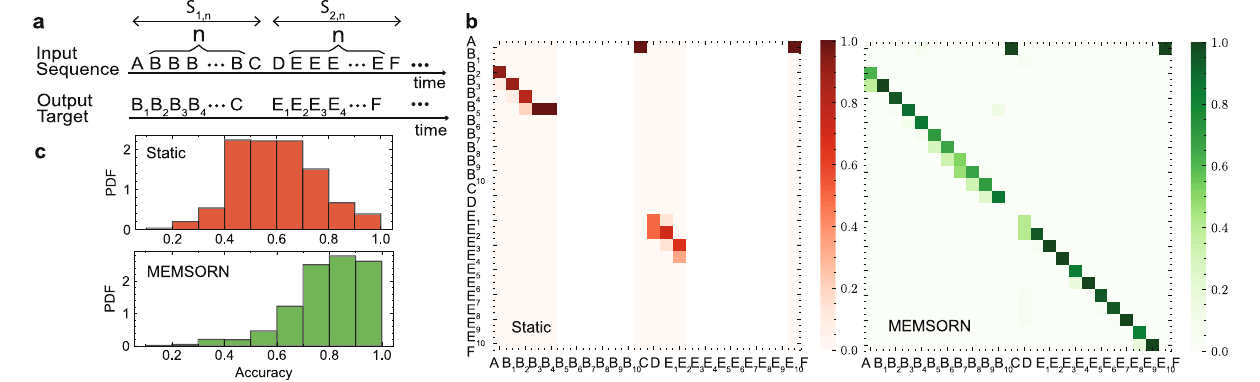
Fig. 4 | Static and MEMSORN performance comparison. a Sequence learning task. Two input sequences of S 1 n = ABB ... BC and S 2 n = DEE ... EF , with B s and E s presented n times, are fed to the network. Each letter represents part of the sequence.Thetaskistopredictthenextsymbolinthesequence,forwhichitneeds to keep the count of the presented B and E symbols. b Confusion matrix for the static (red) and MEMSORN (green) networks. The static network is capable of separating only the fi rst part ofthe sequence, whereas the MEMSORNnetworkcan successfully predict the next letter in the sequence resulting in a diagonal confu- sion matrix. Understandably, the performance drops to chance level between the